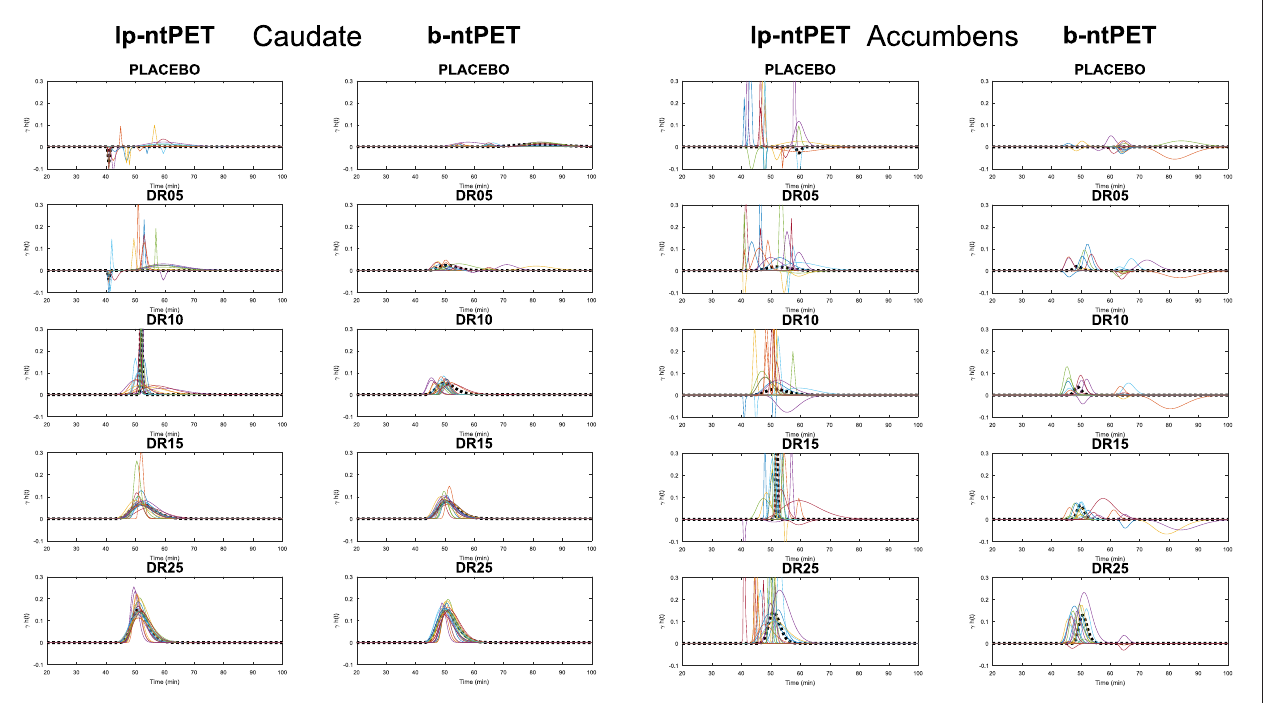
FIGURE 9 | Endogeneous release curves ( γ · h ( t )) estimated by both methods for all conditions. Color lines represent the different subjects. The dashed line corresponds to the release curve estimated from the noiseless TAC by each method (reference). (Left) , caudate; (Right) , accumbens.